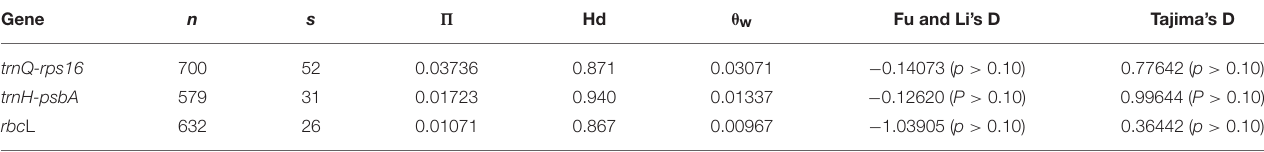
TABLE 4 | Estimates of nucleotide diversity and test statistics for trnH-psbA , trnQ-rps16, and rbc L gene sequences data sets.